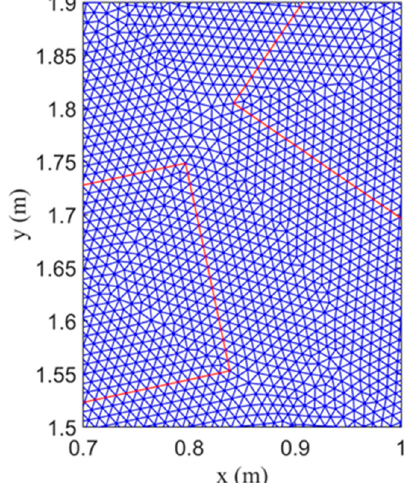
Figure 9. Urban rainfall-runo ff experiment: mesh and representation of buildings (partial area). Table 2. Urban rainfall-runo ff experiment: rainfall schemes.